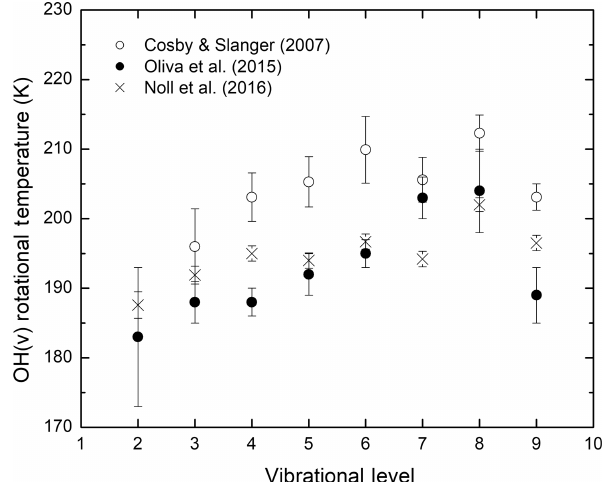
Figure 1. The OH( v ) rotational temperature dependence on the vi- brational level v , as reported by recent simultaneous observations of multiple vibrational levels using high-resolution astronomical in-